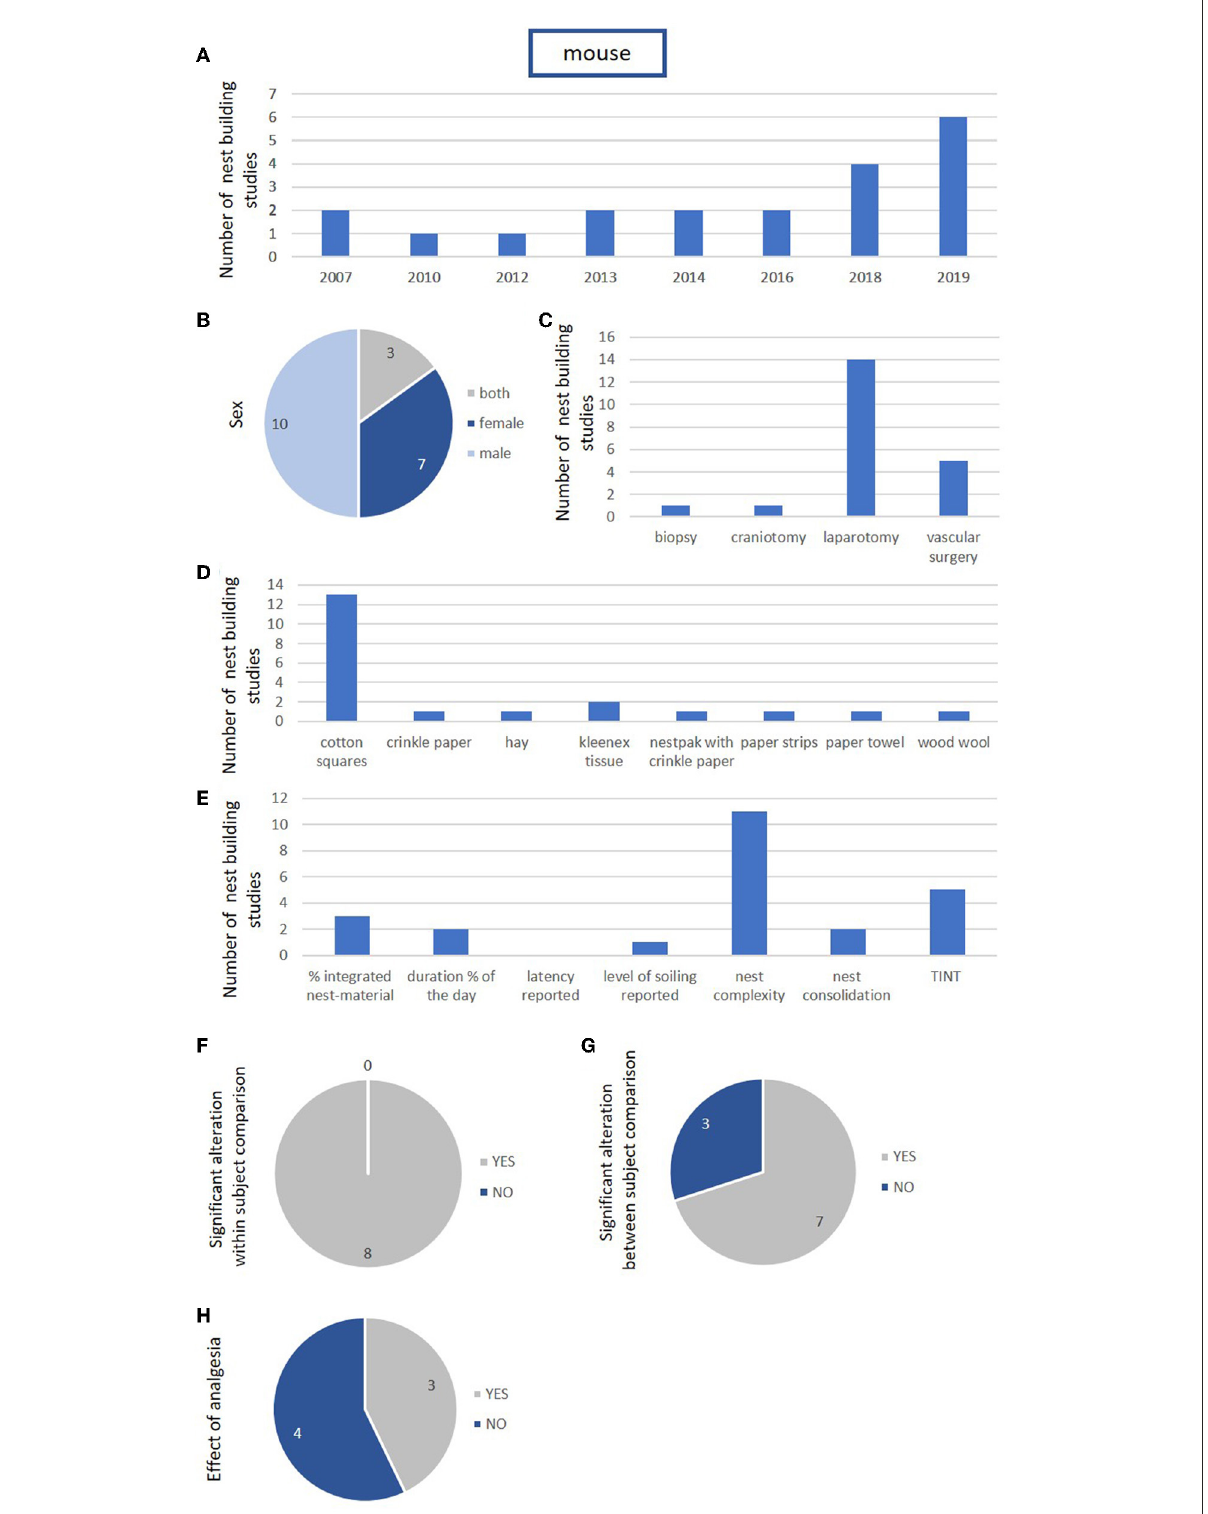
FIGURE3 Study characteristics, animal characteristics, intervention characteristics, and outcome characteristics for nest building in mice (k = 20 studies). (A) Number of published studies using nest building for the assessment of post-surgical pain in mice during the last decade. X-axis represents years. (B) Number of included nest building studies using females, males, and both sexes. (C) Type of intervention in mice. (D) Used nest building material in mice. (E) Reported nest building parameters in mice. (F) Studies describing within-subject comparison in mice. The within-subject comparison revealed an influence of the surgical intervention in all studies. (G) Studies describing between-subject comparison in mice. (H) Studies describing an analysis of the impact of an analgetic drug in comparison with a control